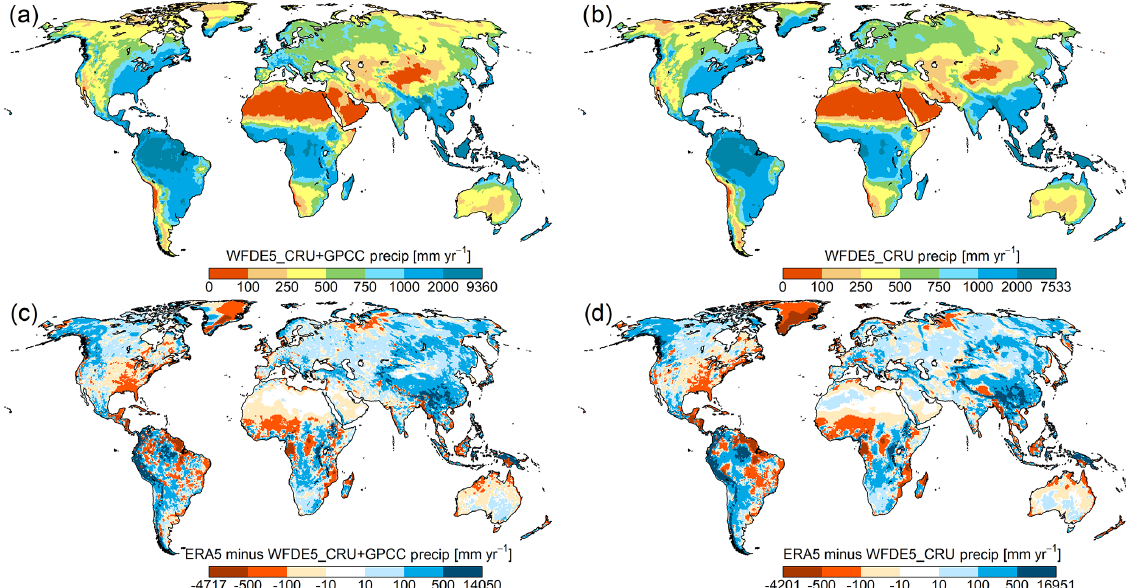
Figure 6. Long-term (1979–2016) average precipitation of the climate forcings, displayed as absolute number for WFDE5_CRU + GPCC (a) , WFDE5_CRU (b) , and differences to ERA5, computed as ERA5 minus WFDE5_CRU + GPCC (c) and ERA5 minus WFDE5_CRU (d) . All values are given in millimetres per